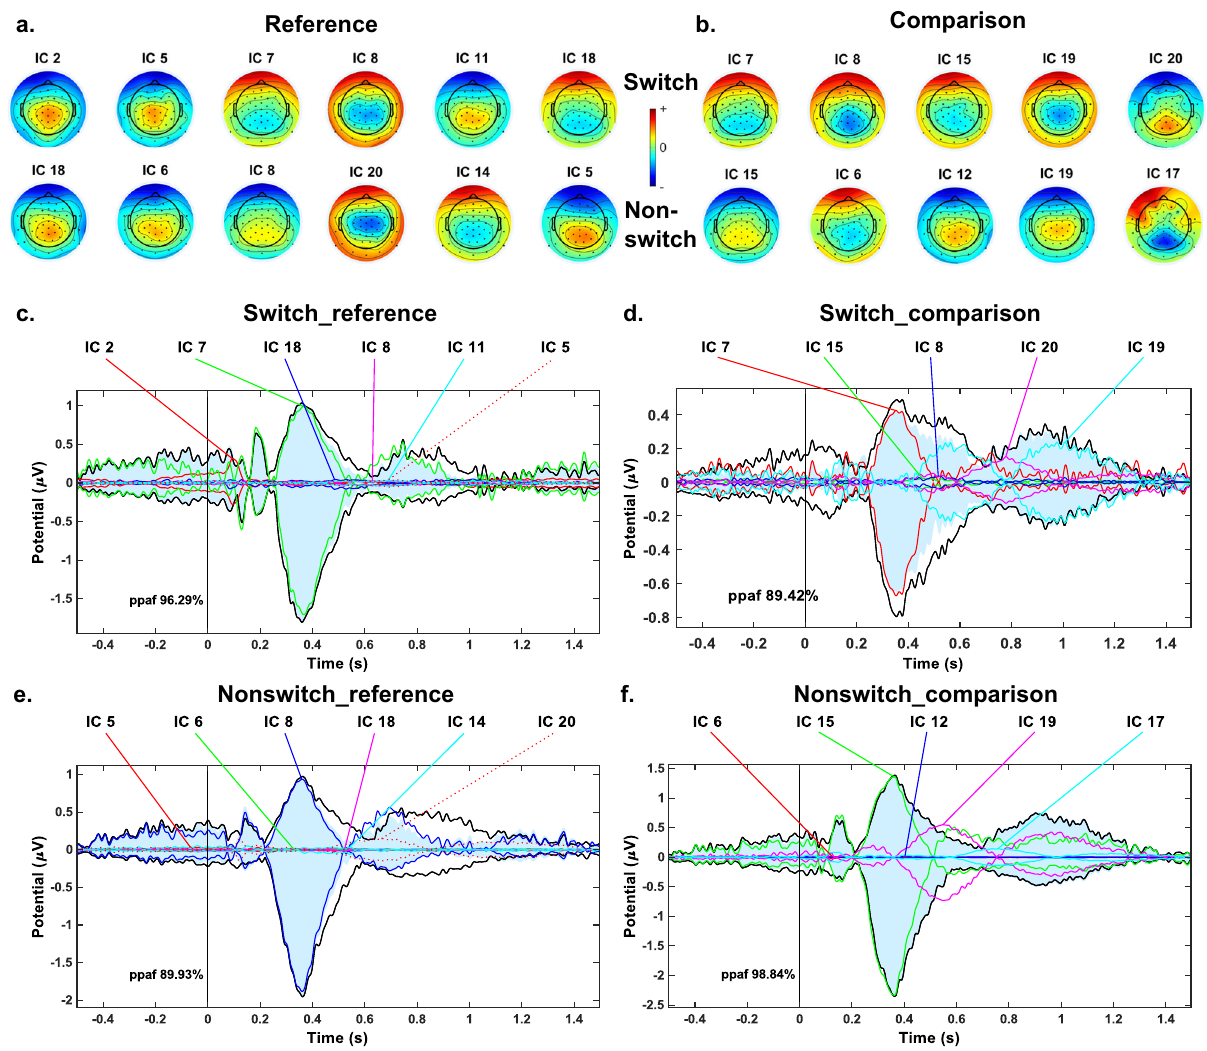
Fig. 2 Similar independent component (IC) pairs and corresponding ERPs for gate opening and closing conditions. Plots a and b show similar IC pairs in gate opening and closing conditions. Each column shows one pair of similar ICs, with the fi rst row representing switch trials and the second-row representing nonswitch trials. Arbitrary units are applied to the scale of the IC topographies. Plots c – f present the component ERPs corresponding to each ICs from plots a and b